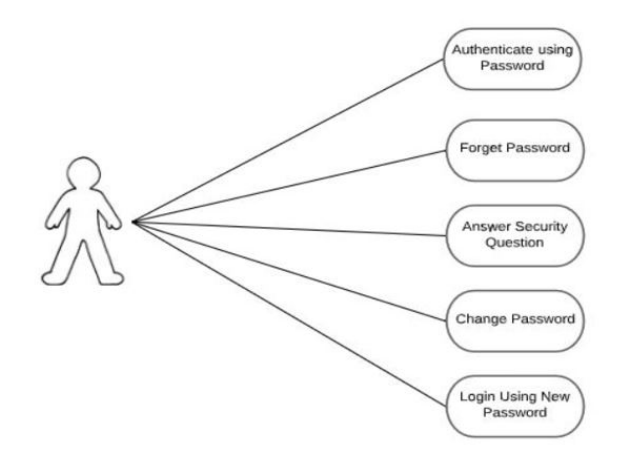
Figure 7. Use case diagram for an existing